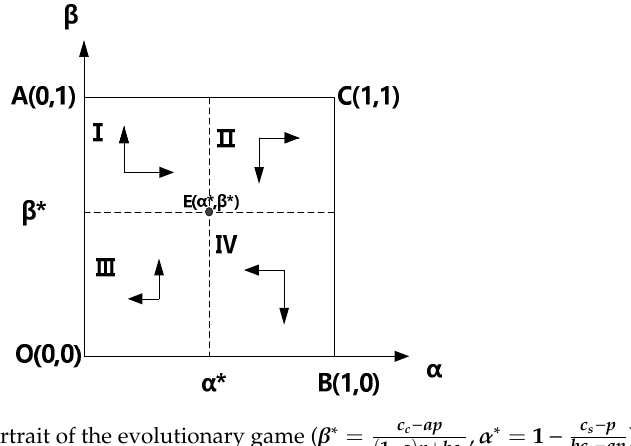
Figure 1. Phase portrait of the evolutionary game ( 𝜷 ∗ = 𝒄 𝒄 (cid:2879)𝒂𝒑